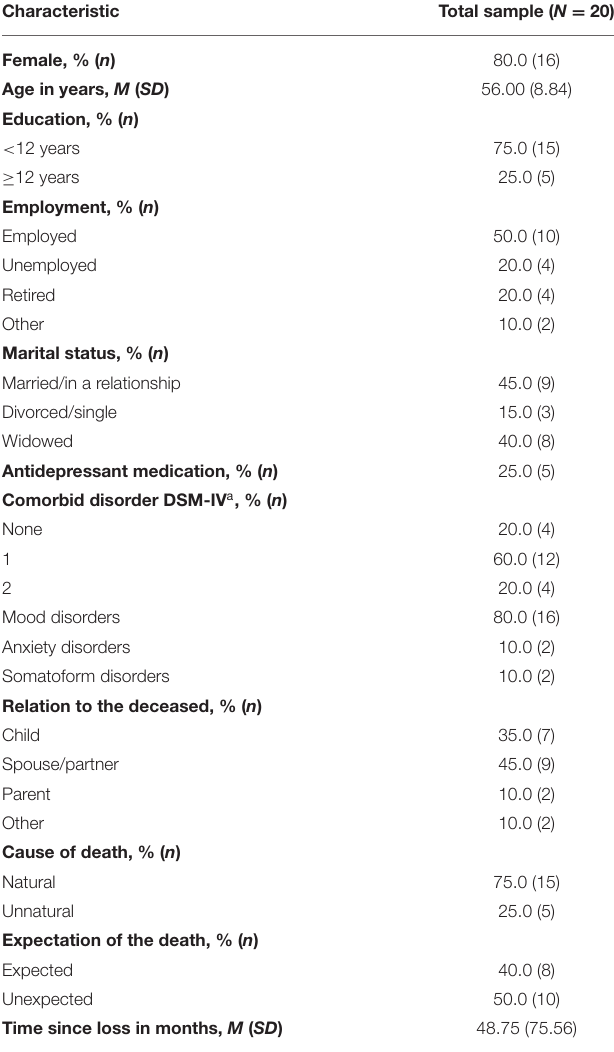
TABLE 2 | Sociodemographic and loss-related characteristics of study participants in the feasibility trial of PCT adapted for PGD.